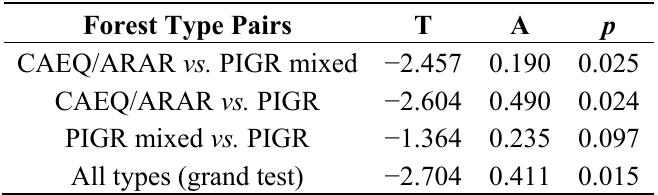
Table 3. Multi-Response Permutation Procedures (MRPP) test results for differences in lichen communities between forest types. “T” is the MRPP test statistic which calculates the difference between observed and expected delta. “A” is the chance-corrected within-group agreement [24] (pp.